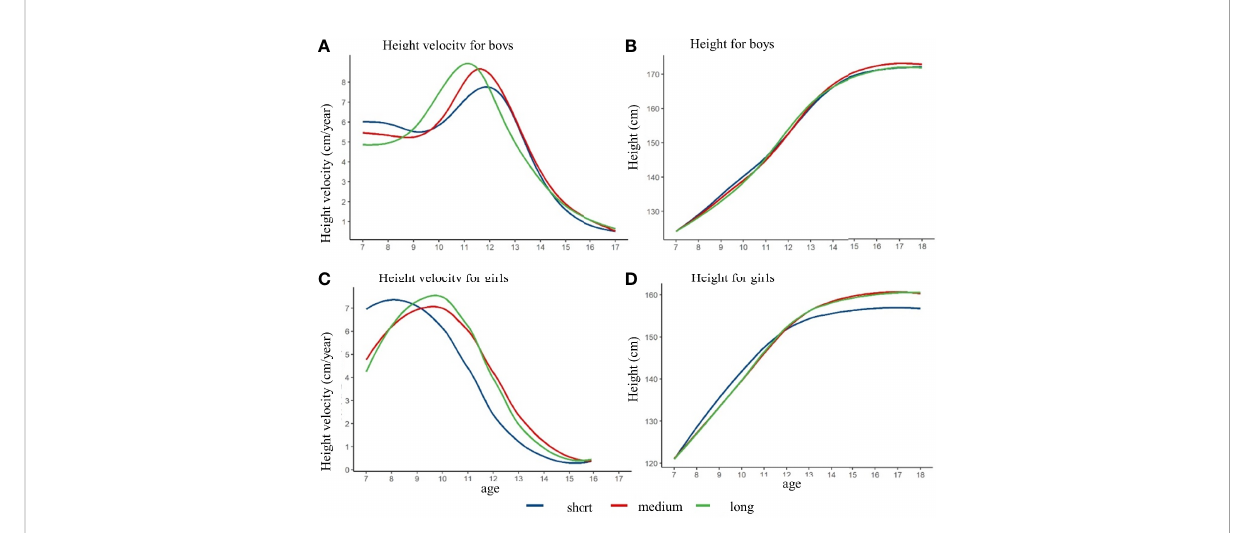
FIGURE 4 The height growth trajectory of boys and girls with different height spurt duration after matching the pre-pubertal height at baseline. (A) height velocity for boys; (B) height for boys; (C) height velocity for girls; (D) height for girls.